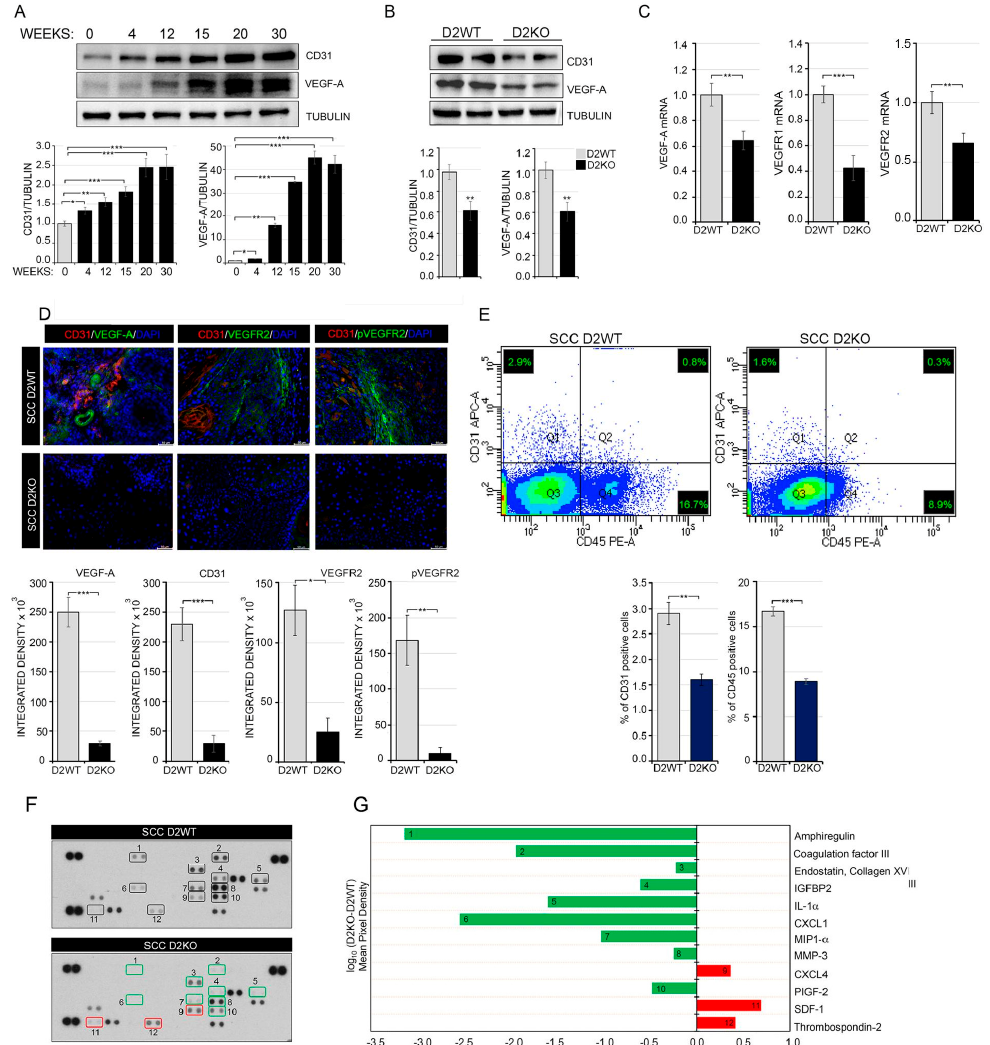
Figure 2. Epidermal attenuation of TH signaling in D2KO mice reduced VEGF-A-induced angiogenesis. ( A ) Western blot analysis of CD31 and VEGF-A expression in SCC skin lesions of mice treated with DMBA-TPA for the indicated times ( n = 8). Quantification of the single protein versus tubulin levels is represented by diagrams (bottom). ( B ) Western blot analysis of CD31 and VEGF-A expression in skin lesions of D2WT and sD2KO mice ( n = 15 for both groups) treated with DMBA/TPA for 20 weeks. Quantification of the single protein versus tubulin levels is represented by diagrams (bottom). ( C ) mRNA expression of VEGF-A, VEGFR1 and VEGFR2 in skin lesions of D2WT and D2KO mice ( n = 15 for both groups). ( D ) CD31, VEGF-A, VEGFR2 and pVEGFR2 immunostaining were performed on paraffin-embedded sections of skin lesions from D2WT and sD2KO mice ( n = 10 for both groups). Scale bars represent 50 µ m. Quantification of single protein levels is represented by histograms (bottom). ( E ) CD31 + endothelial population and the CD45 + lymphocyte population were analyzed by flow cytometry in SCC lesions of D2WT ( n = 6) and sD2KO ( n = 6) mice (bottom). Relative quantification of CD31 + and CD45 + positive cells. Results are expressed as mean ± SD. * p < 0.05, ** p < 0.01, *** p < 0.001. ( F ) Proteome profiler array of differentially regulated angiogenic proteins in D2WT and sD2KO skin lesions. Duplicate spots: 1, Amphiregulin; 2, Coagulation factor III; 3, Endostatin/Collagen XVIII; 4, IGFBP-2; 5, IL-1 α , 6; CXCL1; 7, MIP-1 α ; 8, MMP-3; 9, CXCL4; 10, PIGF-2; 11, SDF-1; 12, Thrombospondin-2. One representative experiment of 4 replicates is shown. ( G ) Relative protein expression was obtained by comparing the mean pixel density of each factor in sD2KO group with each factor in the D2WT group (log 10 (D2KO-D2WT)); up-regulated factors are shown in red, down-regulated factors in green. Next, we analyzed murine ECs lining tumor blood vessels (tumor endothelial cells, TECs) by FACS analysis using antibodies against the EC markers CD31 and CD45. TECs were identified as CD31 + /CD45 - cells, which were derived from SCC skin lesions of D2WT